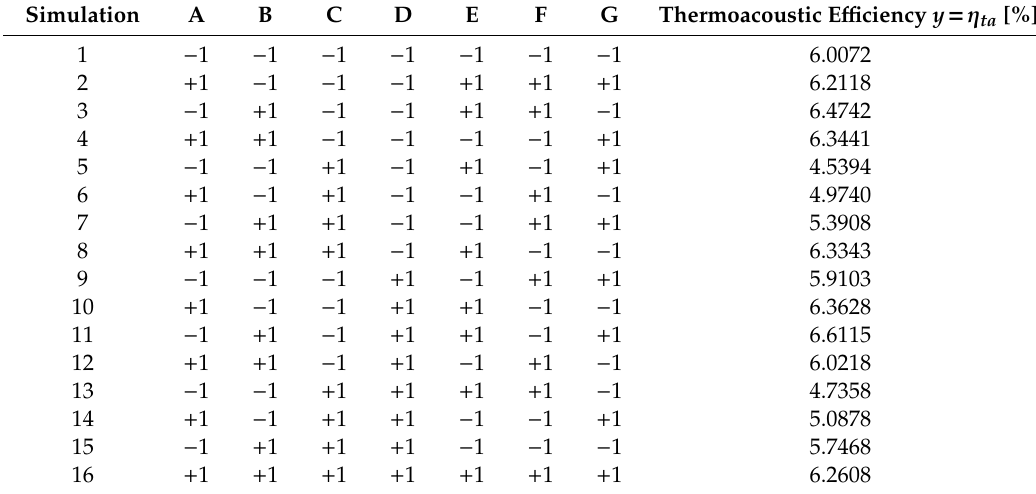
Table 4. Reduced 2 7 − 3 fractional factorial design (FFD) for seven factors and 16 IV